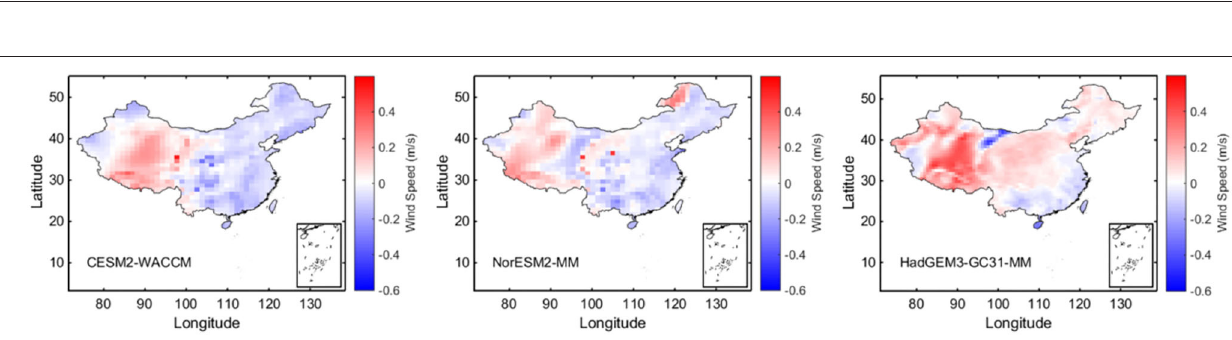
Frontiers in Climate |